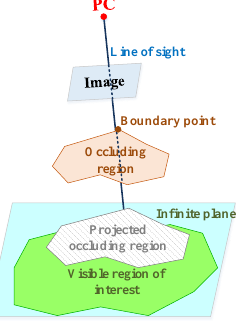
Figure 8. Occlusion analysis of a surface’s boundary point in a given image, (a) intersection point outside of surface boundary (b) intersection point inside surface boundary Once this occlusion detection procedure completed for entire extracted surfaces, the boundary points of the occluding surfaces are projected onto the occluded surfaces to accurately determine their obstructed parts. These occluded parts are identified by overlapping the extracted surfaces of interest with the projected occluding regions onto the infinite plane of that surface (Figure 9).